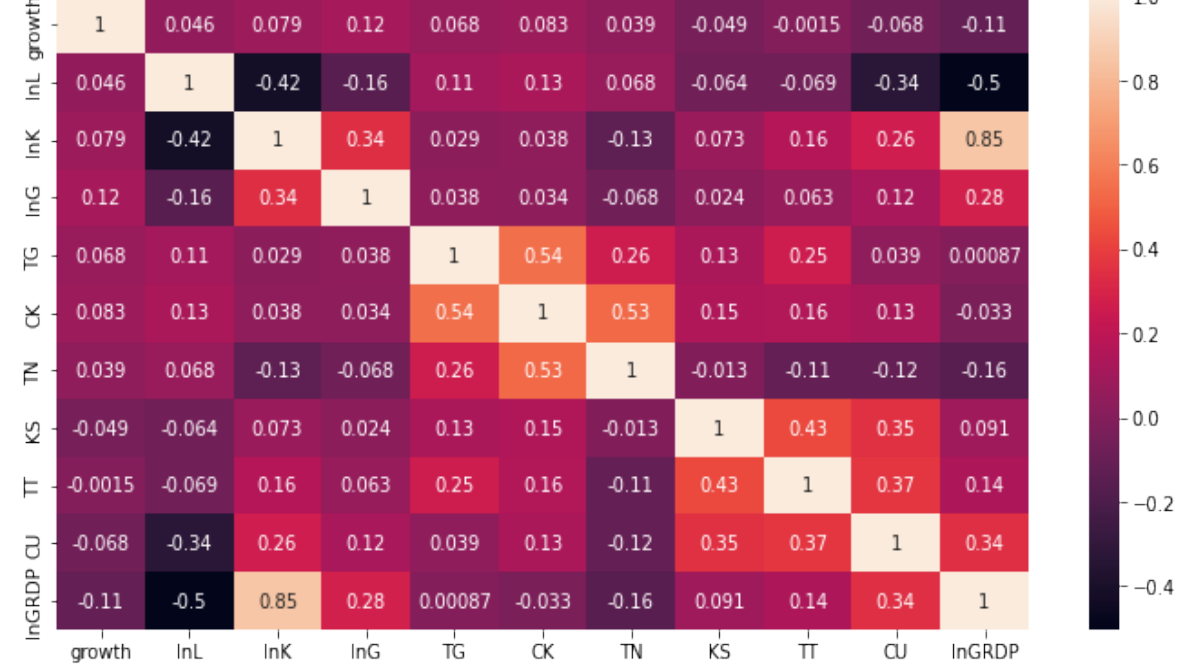
Figure 2. Correlation coefficient matrix.